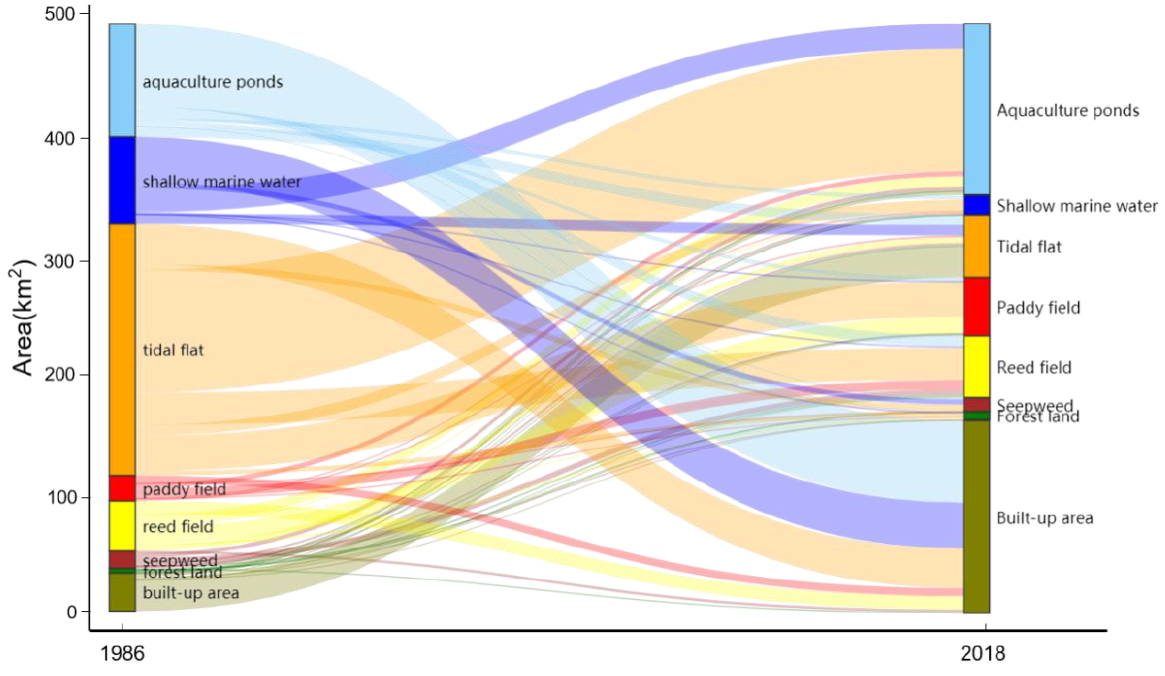
Figure 5. Land cover transitions in the LRE from 1986 to 2018.